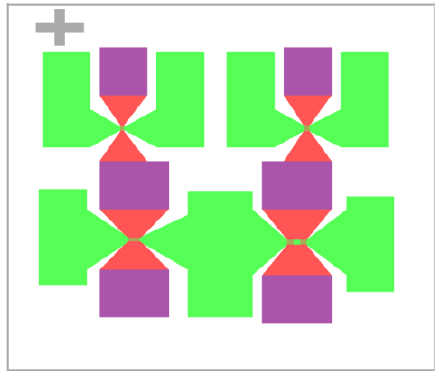
Figure 11. Fuse-logic control chip.